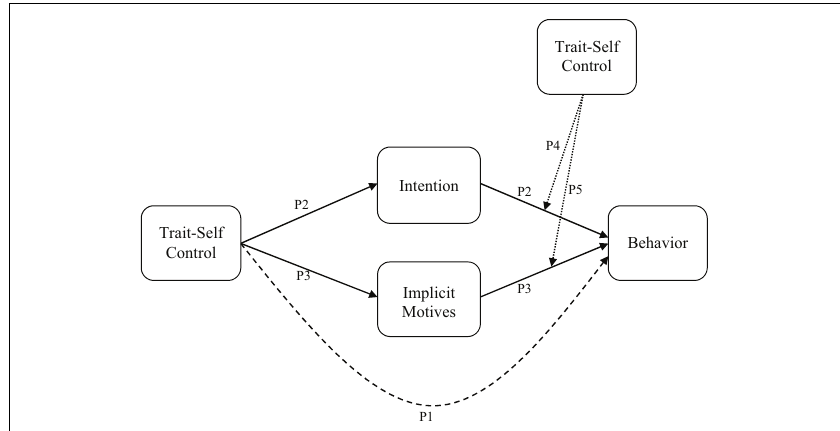
FIGURE 1 | Proposed pathways for trait self-control on behavior. The direct broken path from self-control to behavior (P1) indicates a direct effect proposed to be mediated by the indirect effects through implicit motivation and intention/motivation. The broken lines from trait self-control to the intention-behavior (P4) and implicit motives-behavior pathways (P5) reflects moderation